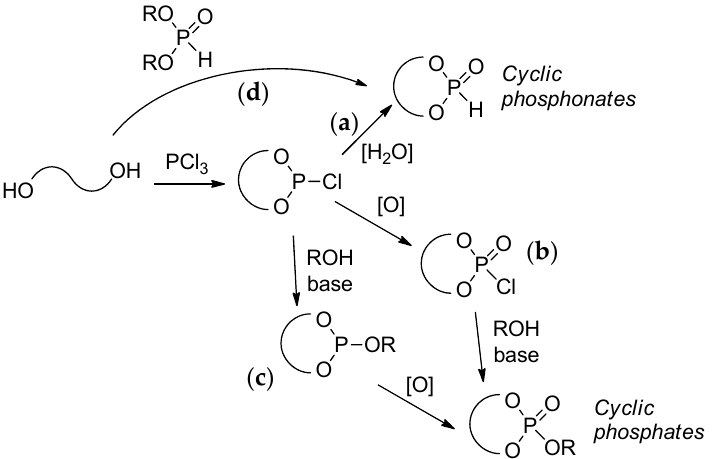
Scheme 9. Common synthetic approaches to cyclic phosphorus-containing monomers for ROP.